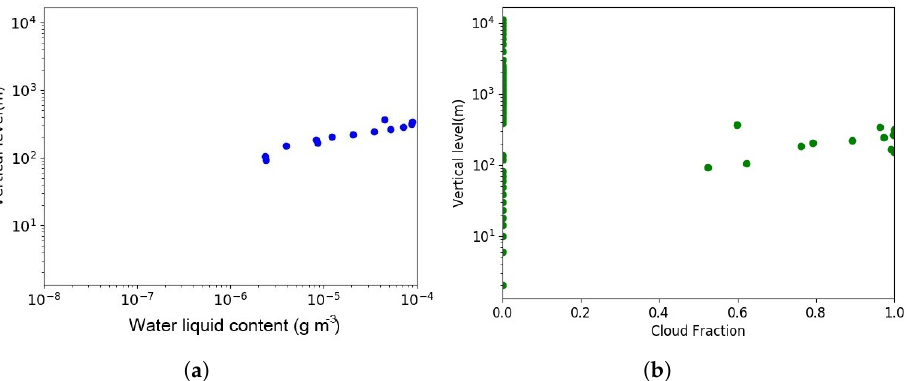
Figure 5. Vertical profile of the liquid water content (in g m 3 ) ( a ) and cloud fraction ( b ) at 0900 (UTC) on the 19 February for the base